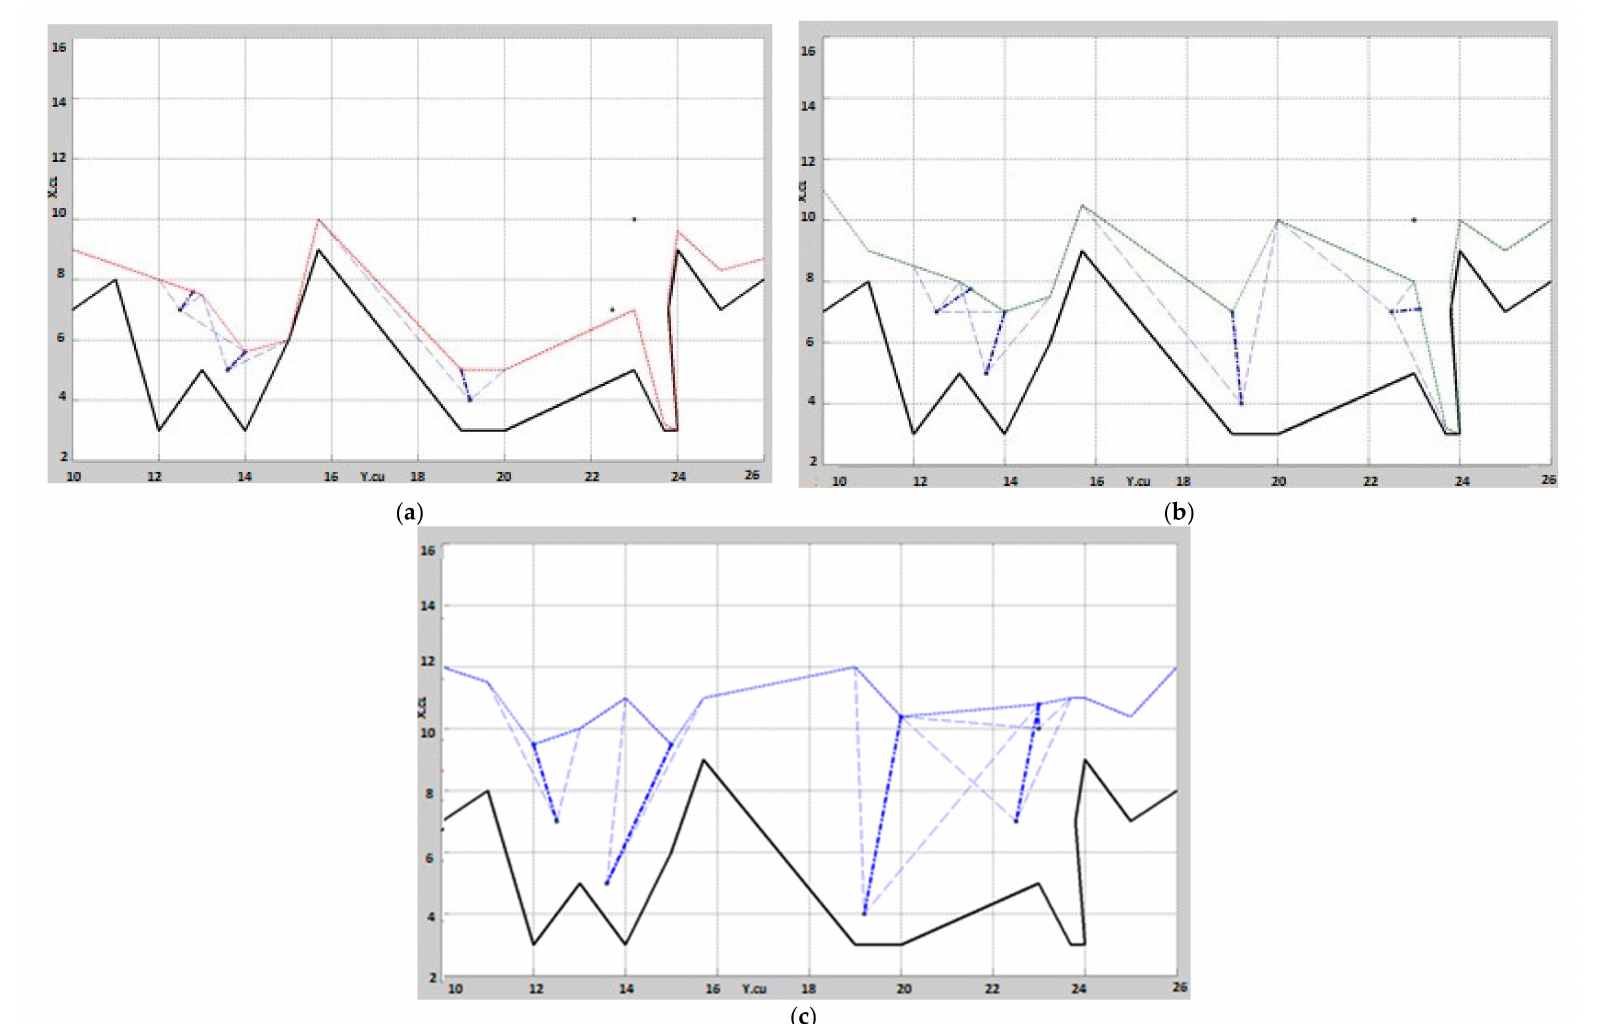
Figure 8. Determination of evacuation points for different levels of flooding. ( a ) First level of flooding. ( b ) Second level of flooding. ( c ) Third level of